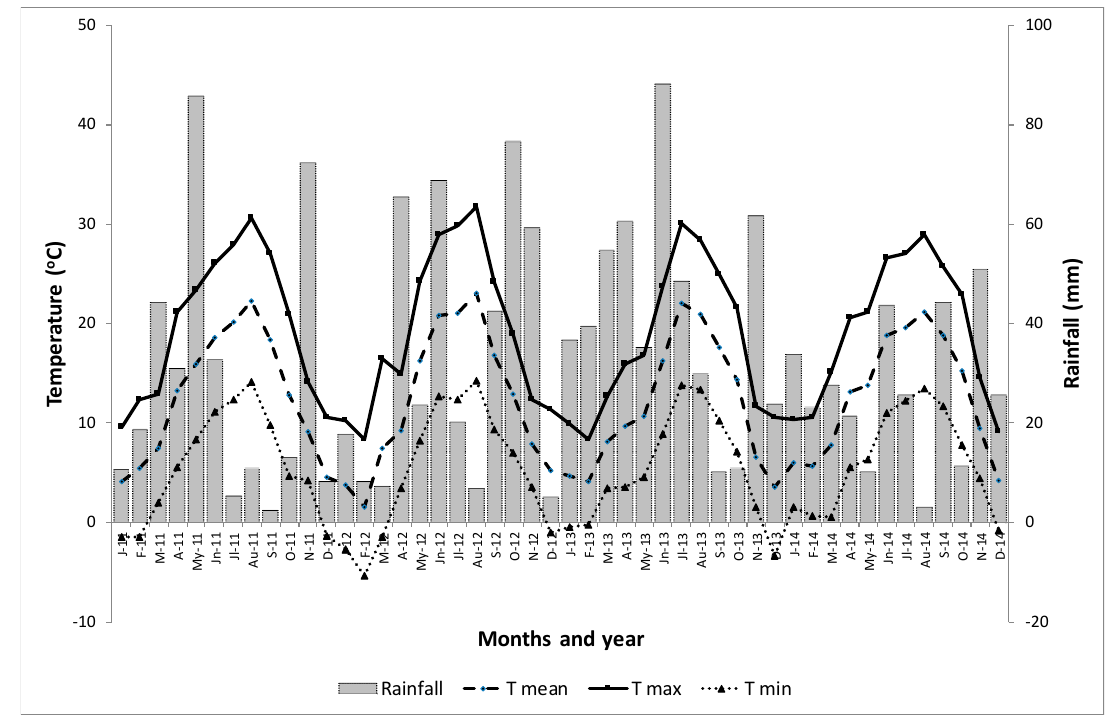
Figure 2. Mean, maximum and minimum monthly temperatures ( ◦ C) and monthly rainfall (mm) of the data collected in the four survey years in Calamocha (Spain) [44].